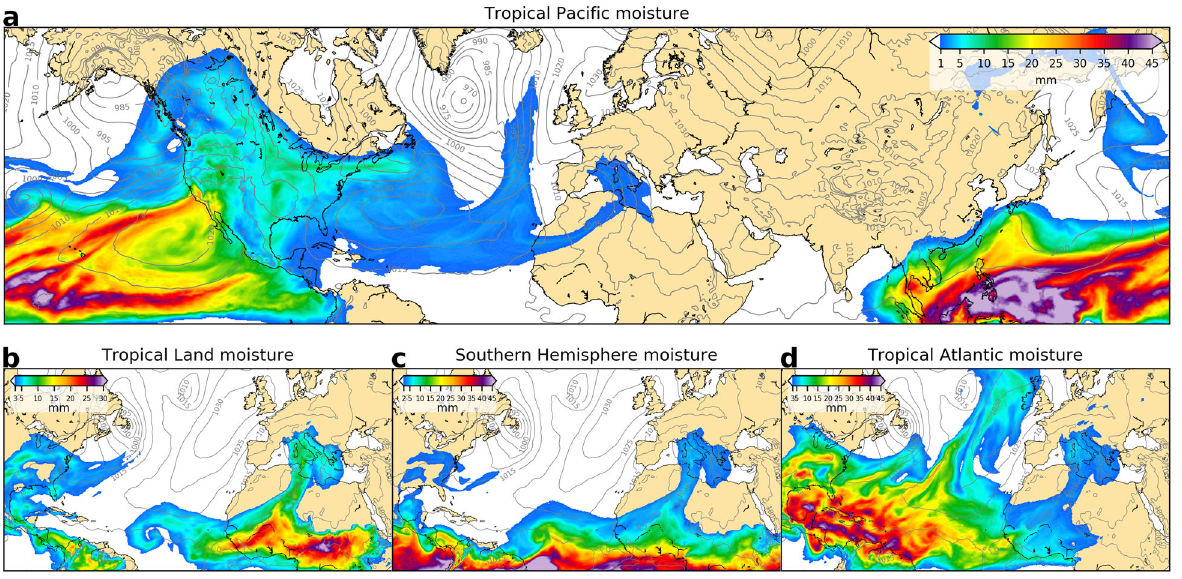
Fig. 4 Tropical moisture exports. Sea level pressure and total precipitable water from evaporation over the tropical Paci fi c during the February 1982 Catalonia (Spain) extreme precipitation event ( a ). The same fi elds but referring to moisture from the tropical land ( b ), the Southern Hemisphere ( c ), and the tropical Atlantic ( d ) during the catastrophic Var (France) fl ood event in June 2010. Fields are shown at 12 UTC on February 16, 1982 ( a ) and June 15, 2010 ( b – d